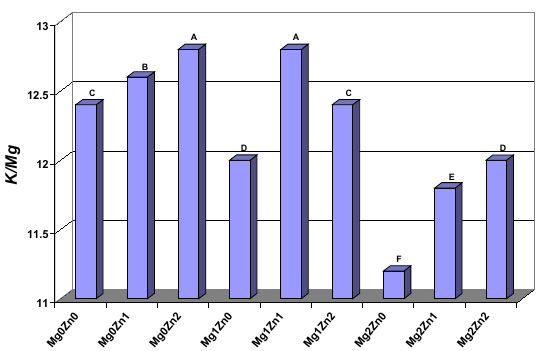
Fig. 4. Effcts of Mg and Zn on the ratio of K/Mg in